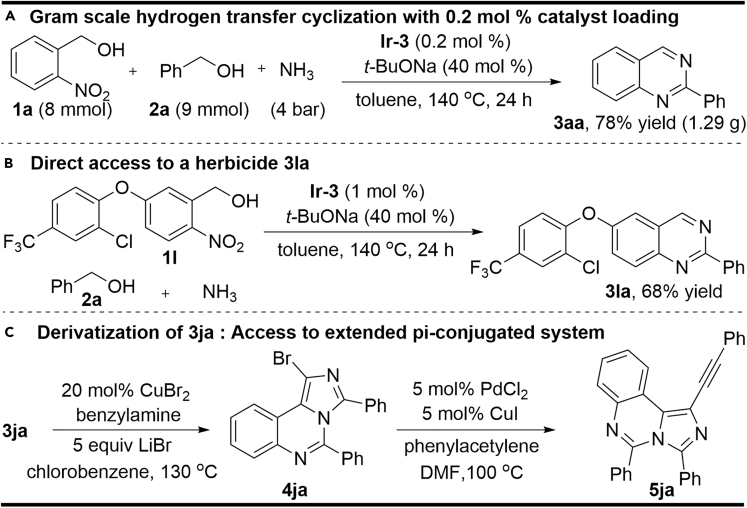
The Synthetic Utility of the Developed ChemistryAlso see Scheme S1 and S3, Figures S92−S97 and Data S3.